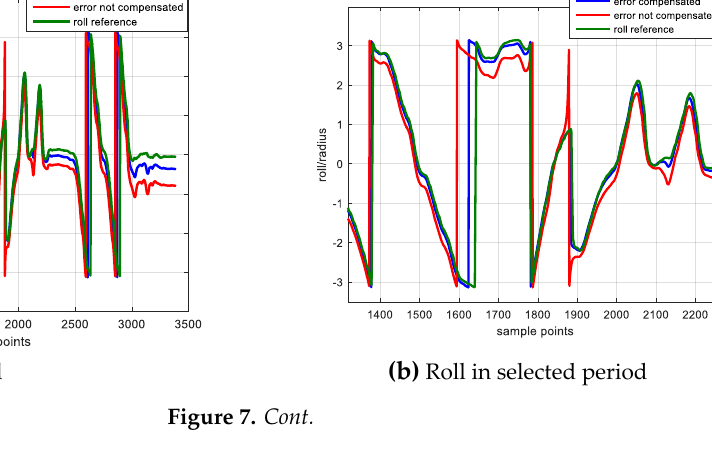
(f) Heading in selected period Figure 7. Comparison of Attitude Result. As shown in the right side three figures which have been enlarged in selected periods, the attitude with error compensation (blue line) is closer to the reference (green line) and the attitude without error compensation (red line) drifts away from the reference. The attitude comparison demonstrates the validation of gyroscope error estimation result because the attitude performance has been improved through well sensor error compensation, while the attitude without error compensation has a poorer performance. The attitude error result and its statistical result are shown in Figure 8 and Table 12